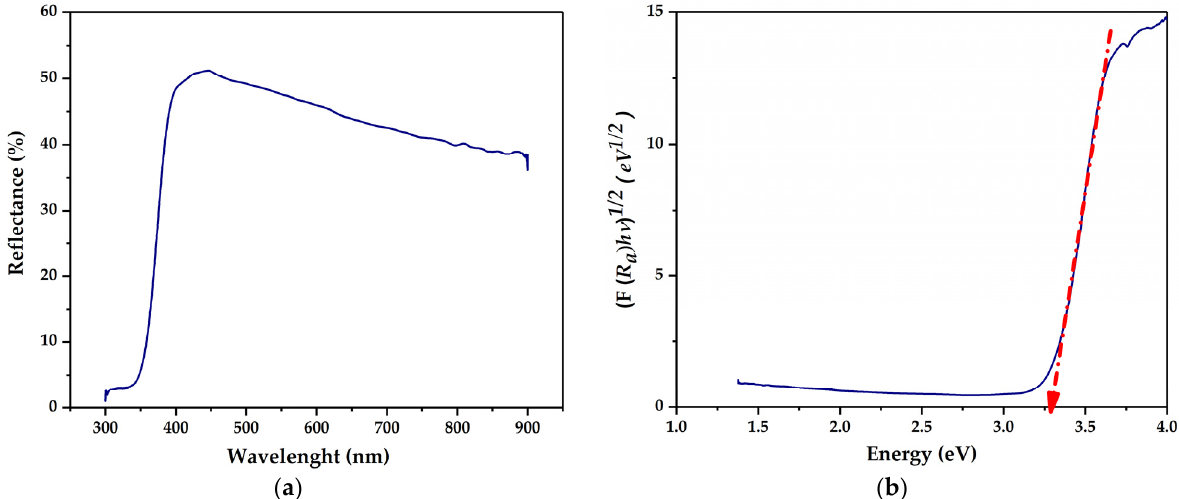
Figure 2. ( a ) Diffuse reflectance spectrum; ( b ) relation of (F (R α ) h ν ) 1/2 vs. the energy of the Ti/TiO 2 electrode.